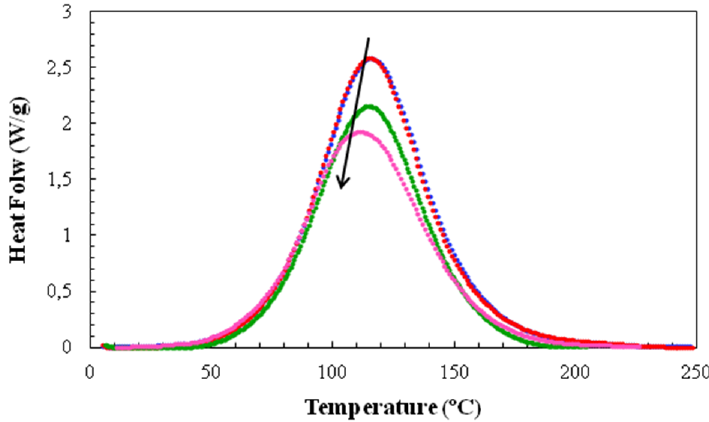
Figure 5. DSC scans for the non-isothermal cure at 20 °C/min of the resin/HBP system without clay (blue curve) and for the nanocomposites with 2 wt% (red), 5 wt% (green) and 10 wt% (pink) clay content. The arrow indicates the direction of increasing clay